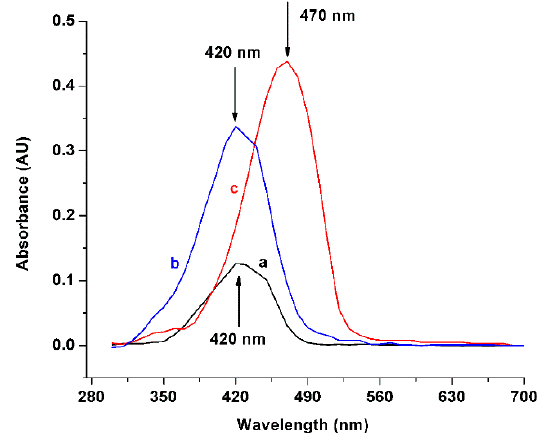
Figure 4. Ultraviolet-Visible spectrophotometric scanning of curcumin. (a) Absorption in methanol, maximum peak of absorption found at 420 nm; (b) Absorption in neutral medium, maximum peak of absorption found at 420 nm; and (c) Absorption in basic medium, maximum peak of absorption found at 470 nm.